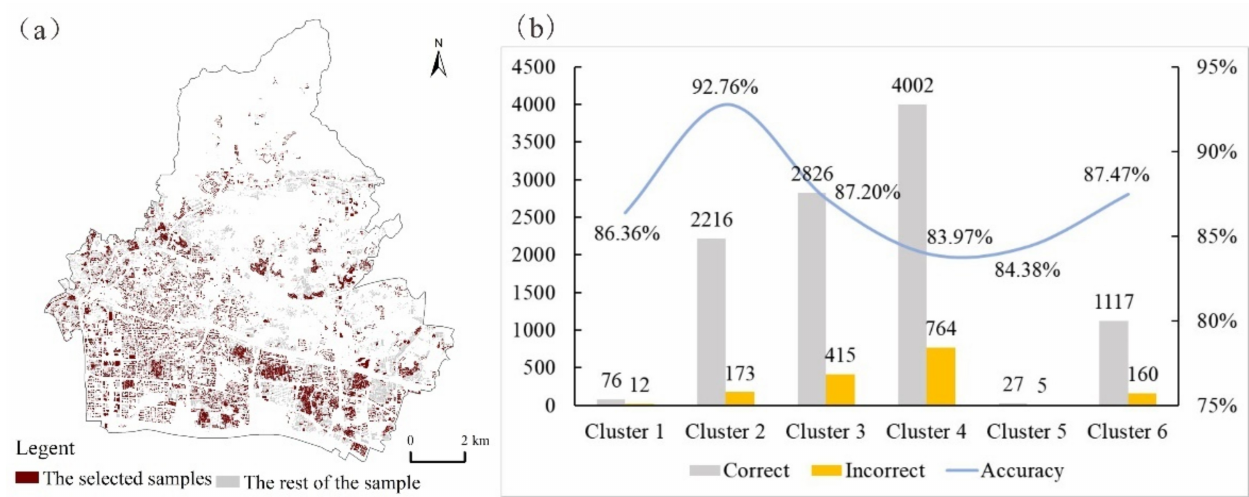
Figure 7. The Spatial distribution of validation samples and the accuracy of the clustering results. ( a ) Sample buildings ( b ) Accuracy of the